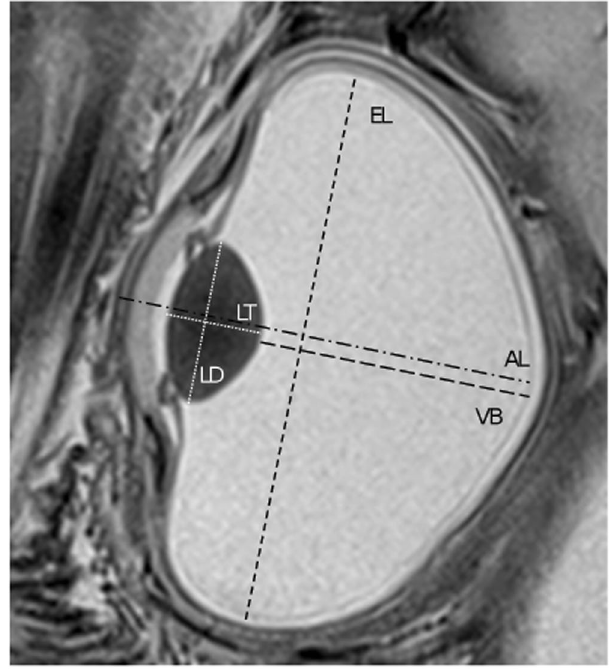
Figure 2. T2-weighted in vivo MR image of a chick embryo eye with intraocular dimensions depicted here schematically, as measured using OsiriX © : axial length of the eyeball (AL), equatorial length of the eyeball (EL), lens thickness (LT), lens diameter (LD) as well as vitreous body distance